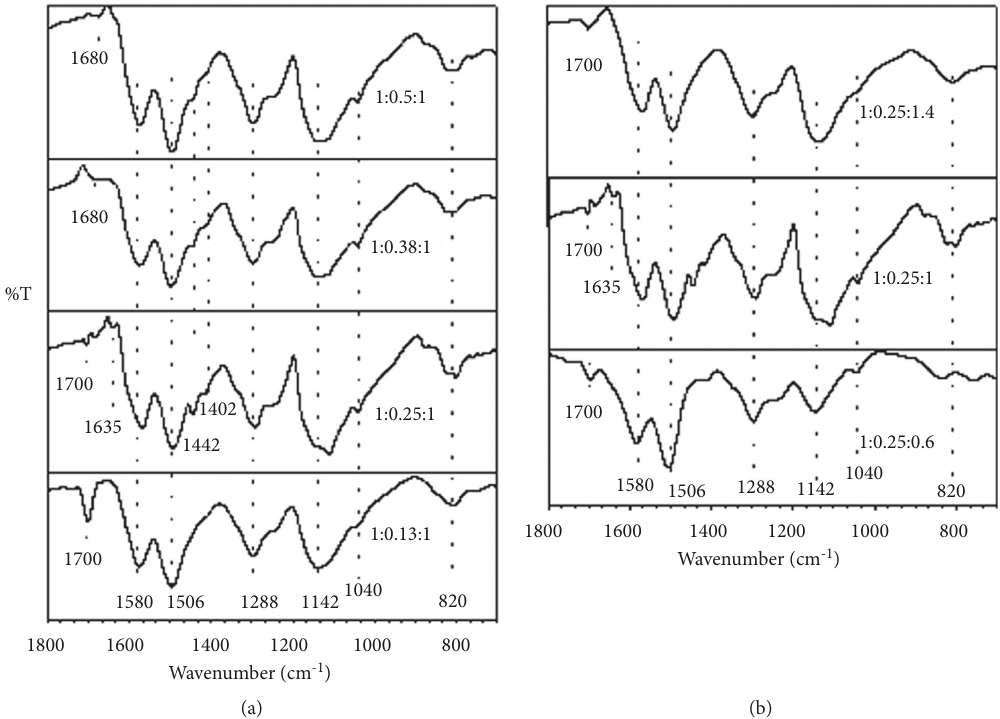
Figure 3: Analyses of polyaniline synthesized at different molar ratios of aniline:GA and APS were performed using FTIR. For the sake of comparison, the spectrum from the 1:1.25:1 sample is